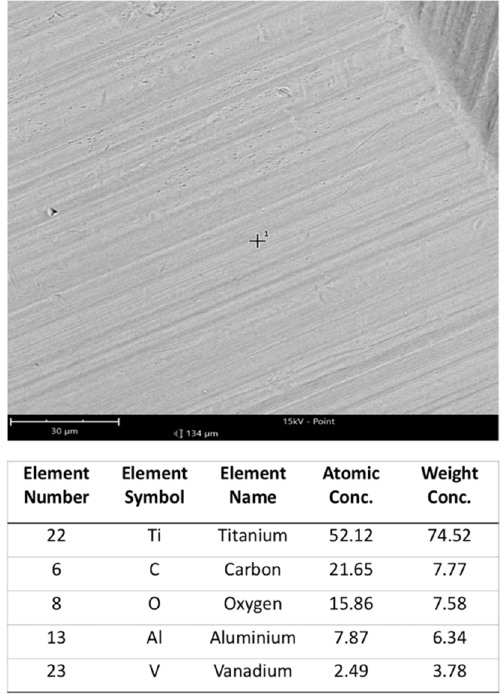
Figure 2. On top, the machined clean titanium plate at SEM. FOV: 134 µm, Mode: 15 kV—Point, Detector: BSD Full. On bottom, the chemical composition analysis of the titanium surface, in spot 1, pointed by a cross in the figure.